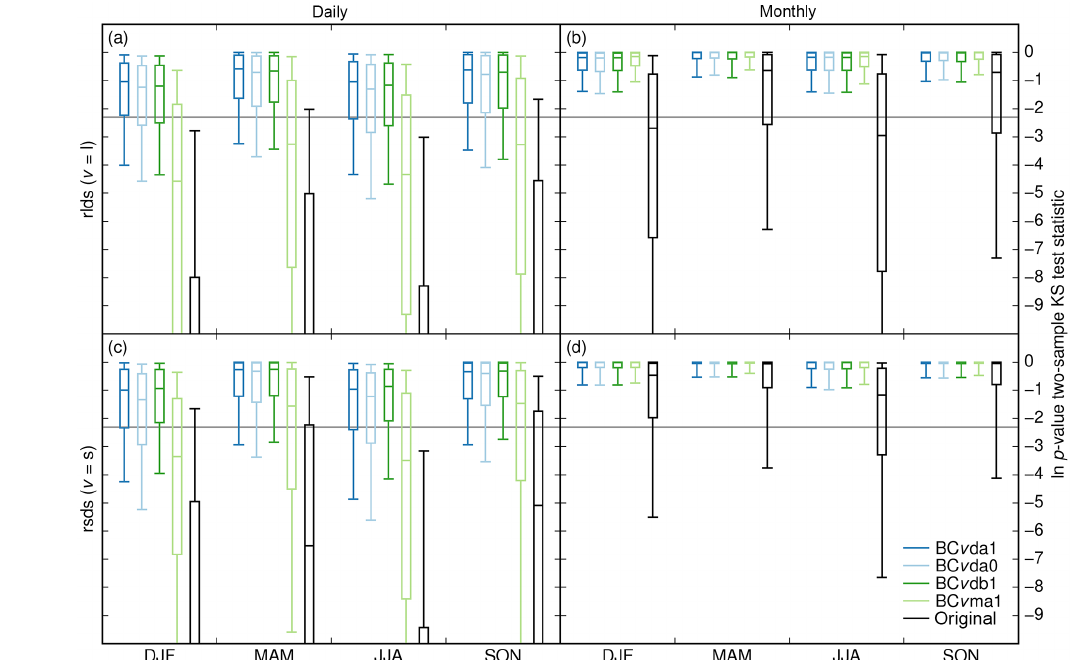
Figure 5. Overall performance of bias correction methods BC v da1, BC v da0, BC v db1, and BC v ma1 for longwave (top) and shortwave (bottom) radiation at the daily (left) and monthly (right) timescales as quantified by p values of two-sample Kolmogorov–Smirnov test statistics of the respective E2OBS and SRB data before (black) and after (colours) bias correction (see Appendix C; greater p values indicate stronger agreement of E2OBS and SRB distributions). The p values are determined individually for each grid cell, season, and calibration data sample, with all corresponding values pooled into one distribution and omitting shortwave radiation data from months with average rsdt less than 1Wm − 2 . The horizontal lines of each box–whisker plot represent the 90th, 75th, 50th, 25th, and 10th (from top to bottom) grid-cell area-weighted percentiles of the natural logarithms of these p values over calibration data sample (1sthalf, 2ndhalf), latitude, and longitude. The grey horizontal line marks the p = 10% significance